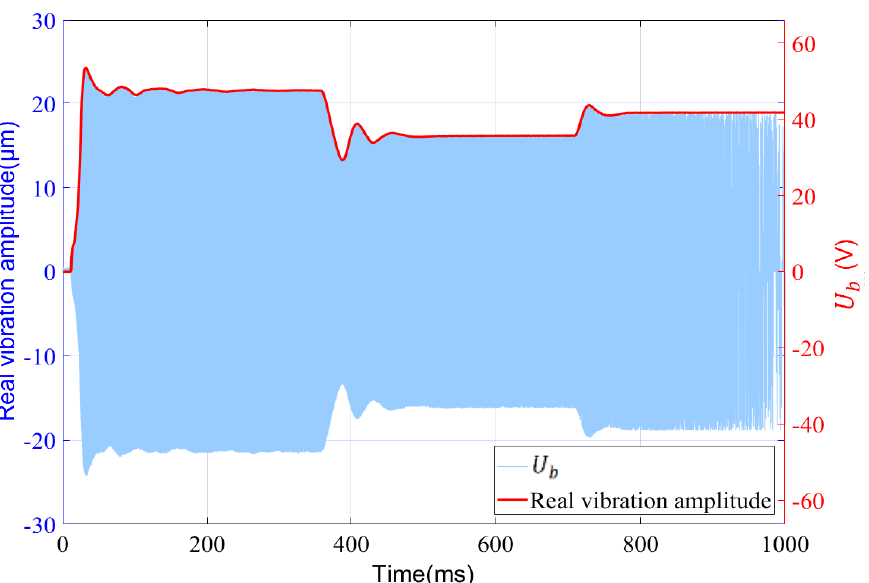
Figure 10. Comparison of piezoelectric the partial voltage signal and the measured vibration dis- placement.